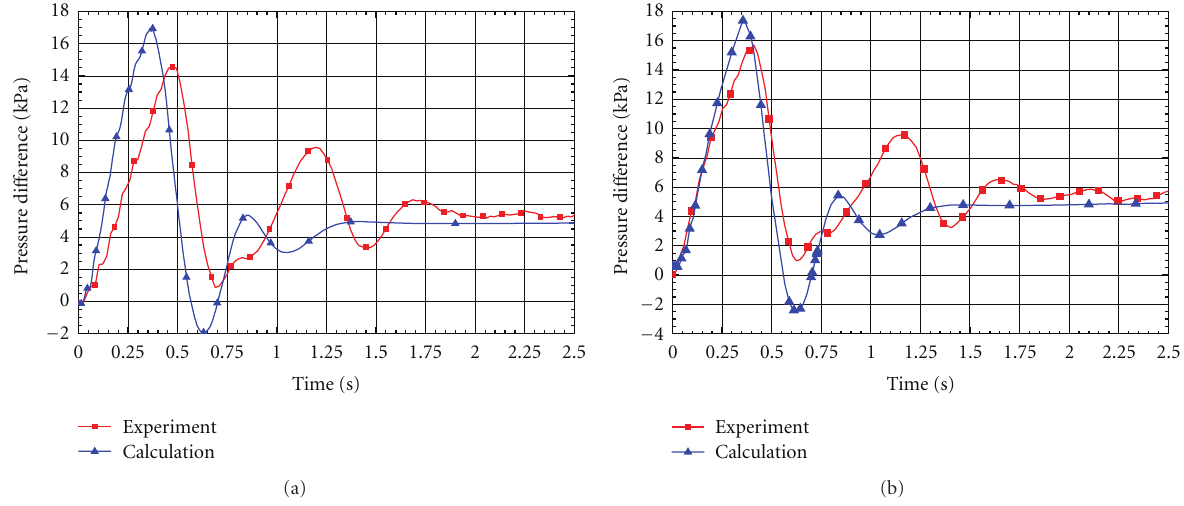
Figure 10: Experimental and calculated pressure di ff erence across BC walls. (a) Test 4; (b) Test 5.